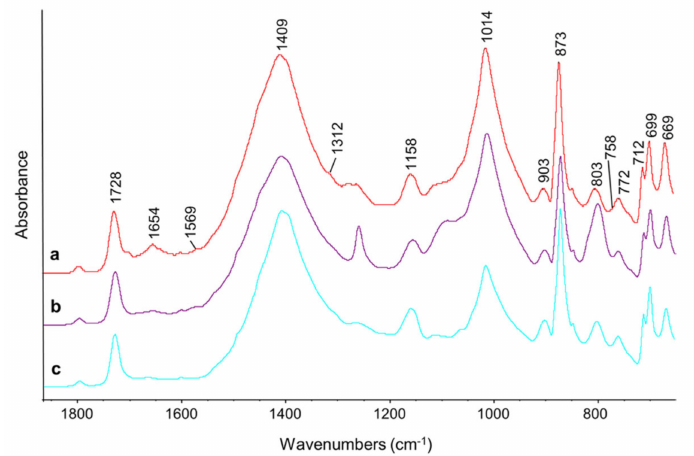
Figure 4. FTIR spectra of unprotected (np) and protected (wp) areas of mock-up A treated with laser (6 Hz, fluence of approximately 2.60 J / cm 2 , on wet surface). Labels in spectrum a show the absorptions due to the red styrene-acrylic residues. (a) A_IV_np_wet; (b) A_IV_wp_wet; (c) reference green styrene-acrylic